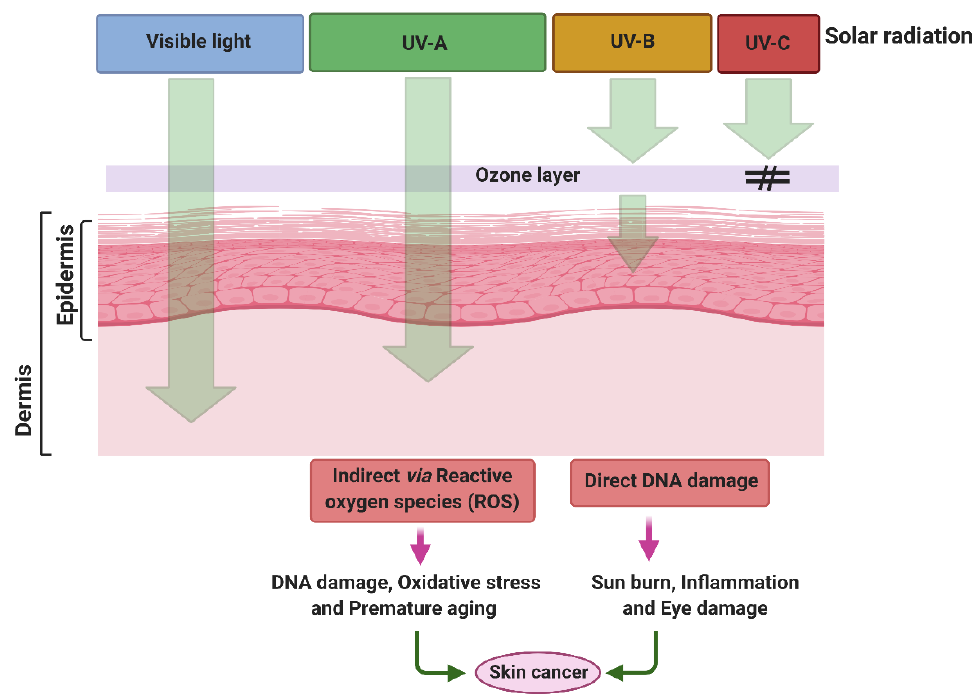
Figure 1. Penetration of UV radiation into the skin layer and their adverse effects. Created with BioRender (https://biorender.com/ accessed on 15 April 2021).